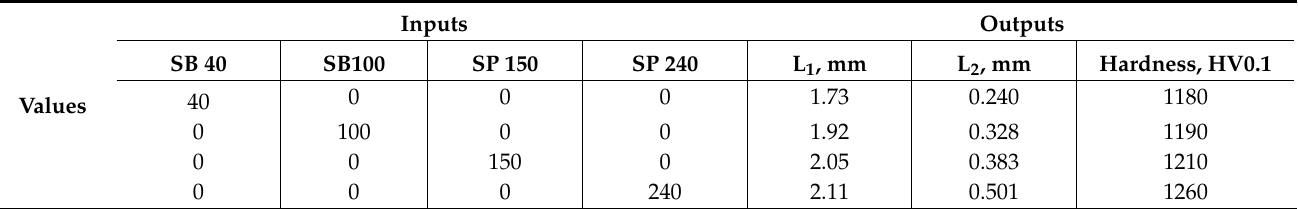
Table 6. Values of geometry and hardness from the fuzzy system and experimental data. Parameters